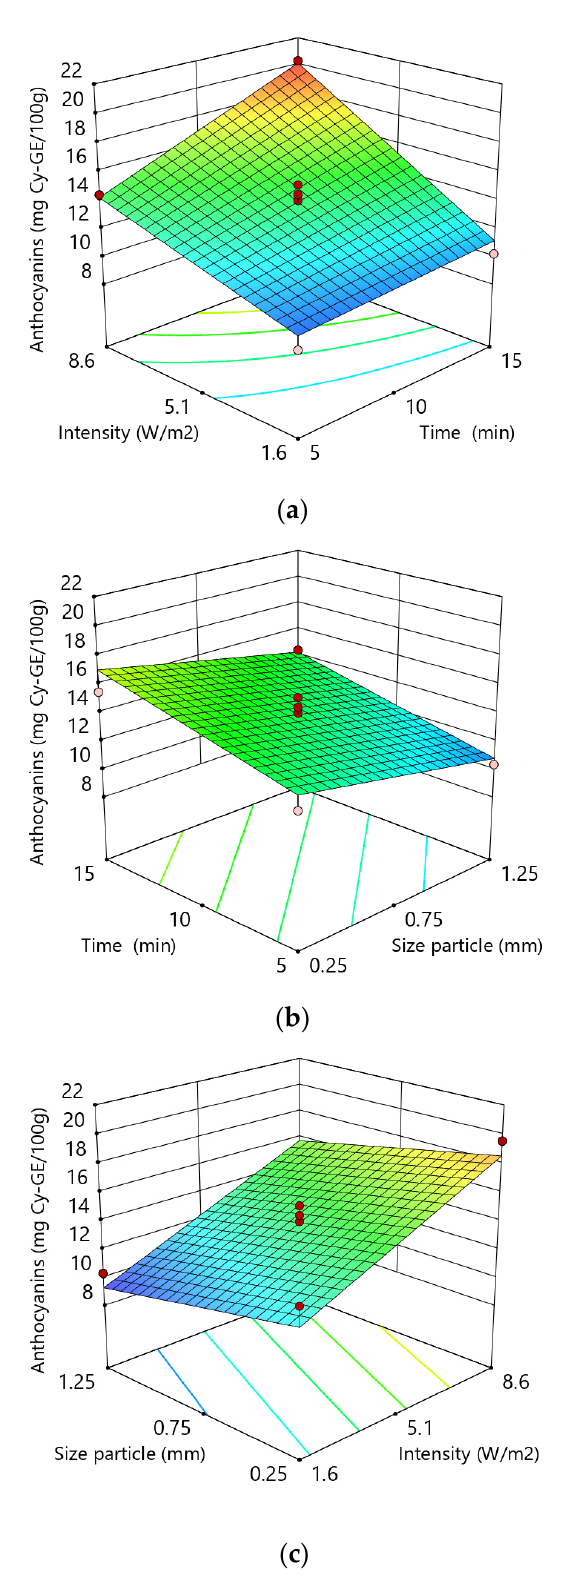
Figure 3. Response surfaces obtained with the Box–Behnken experimental design for the total anthocyanin content (mg Cy-GE ∙ 100 g − 1 ) in hemp depending on the ( a ) intensity and time, ( b ) particle size and time, and ( c ) particle size and intensity.